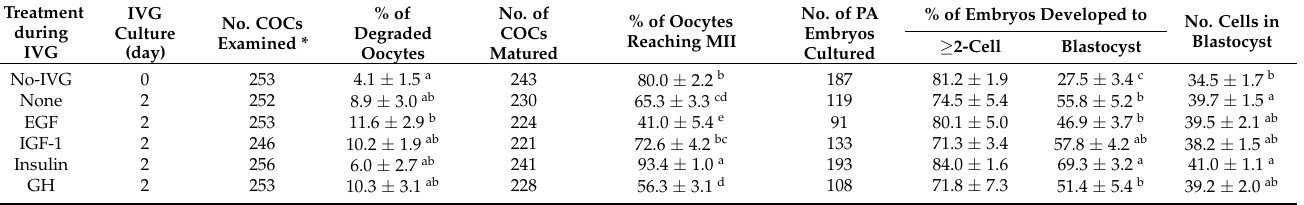
Table 1. Effect of growth factor and hormone treatment during in vitro growth (IVG) culture on oocyte maturation and embryonic development after the parthenogenesis (PA) of pig oocytes derived from small antral follicles.